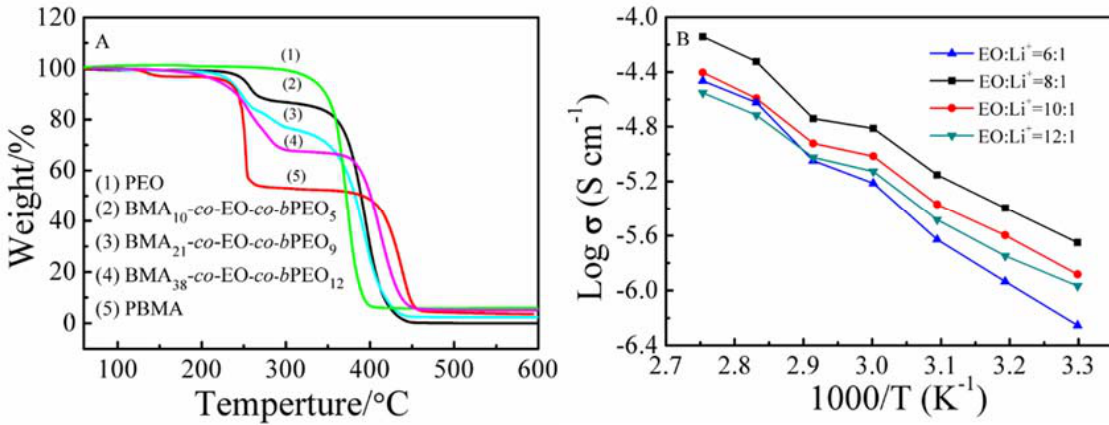
Figure 3. ( A ) TGA curves of PEO, PBMA and their copolymer products, ( B ) ionic conductivity with different EO:Li + of BMA 38 - co -EO- co - b PEO 12 .